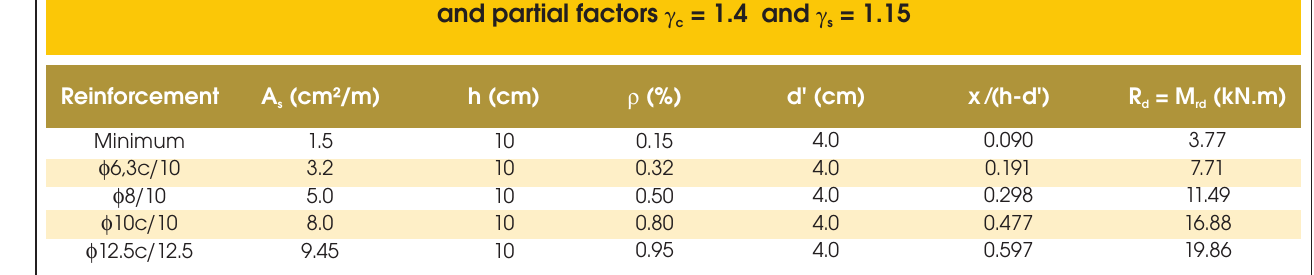
Table 4 – Sections of concrete flat slab analyzed and design resistance